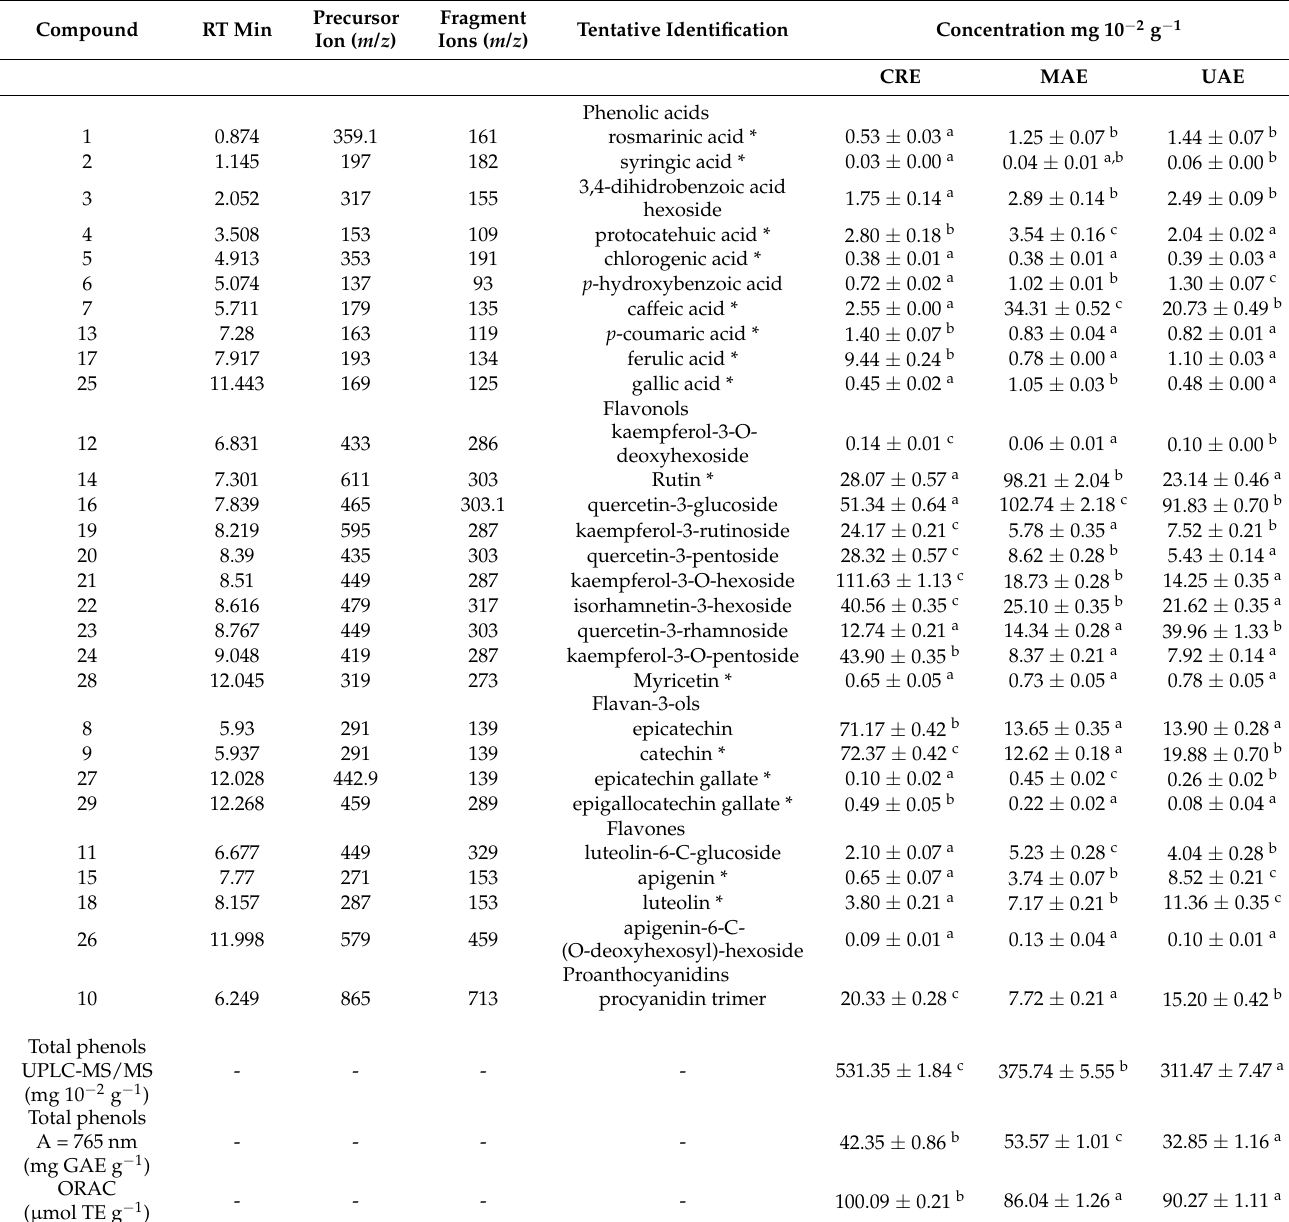
Table 3. Mass spectrometric data and identification of phenolic compounds in Laurus nobilis L. leaves obtained by optimized extraction